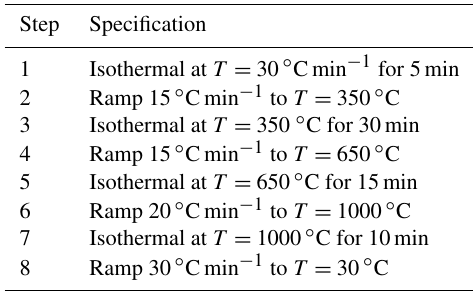
Table A2. Heating program used for thermogravimetric analysis of soots in a pure N 2 atmosphere. Step